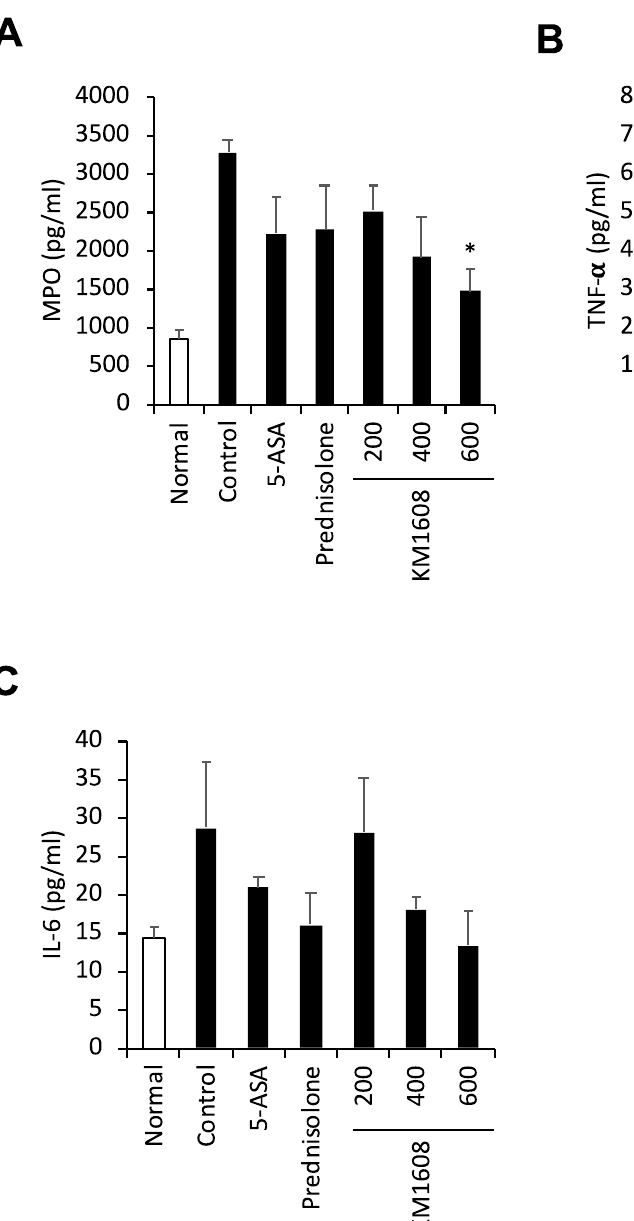
Figure 5. KM1608 inhibits the inflammatory factors involved in TNBS-induced colitis. Colitis was induced in ICR mice by the intrarectal injection of TNBS. The animals were treated with KM1608 (200, 400, and 600 mg/kg), 5-ASA (200 mg/kg), and prednisolone (5 mg/kg) orally once per day. 5-ASA and prednisolone were used as the reference drugs. The MPO, TNF- α , and IL-6 levels in the colon tissue lysates were measured by using ELISA kits ( A – C ). The data are presented as the mean ± SEM of three independent experiments. * p < 0.05 vs. control.